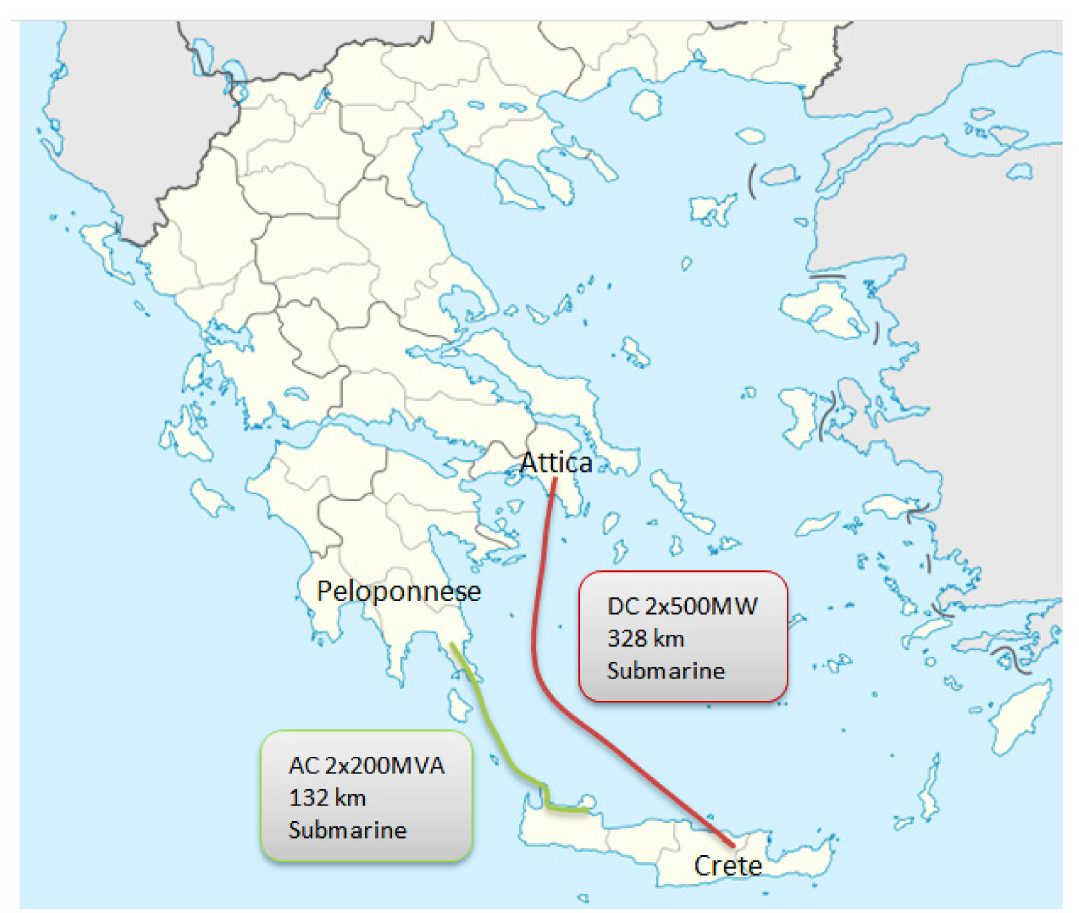
Figure 3. How Crete is connected to the mainland according to the National TYNDP